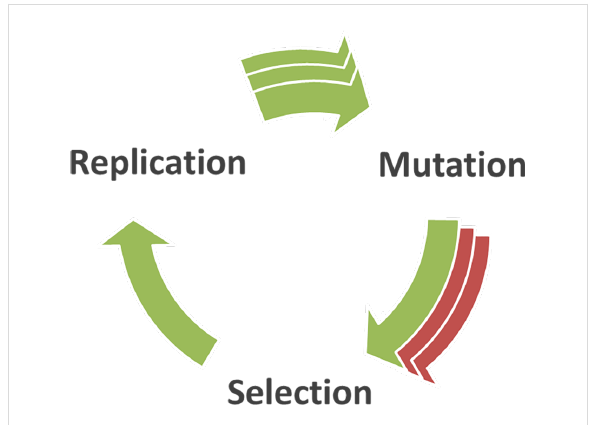
Figure 1: Three processes involved in Darwinian evolution. Species must be replicated to obtain a large population. During the replication process mutations can occur, on which natural or artificial selection can then take